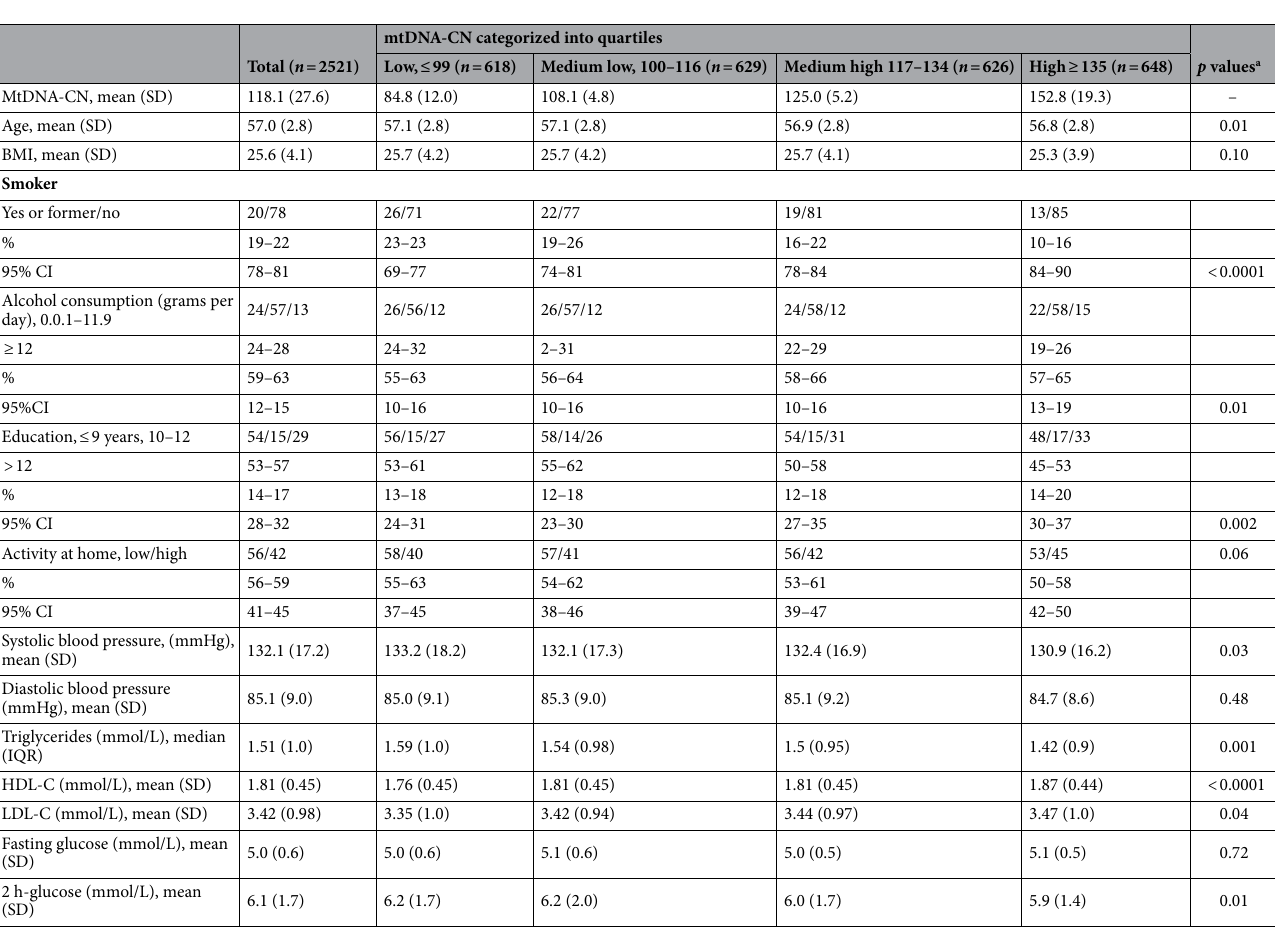
Table 1. Baseline characteristics of study subjects according to the levels of mtDNA-CN. a Test for association between mtDNA-CN and characteristic using ordinal logistic